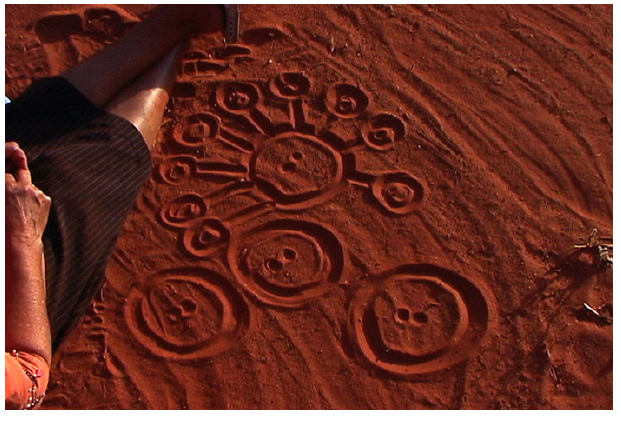
Fig. 4. Sand drawing by Veronica Dobson to illustrate Plant food–Dreaming–Country–People and the elements or values associated with one domain. This drawing of the four domains and some elements preceded that in Fig. 4. (From Dobson et al. 2008, Photo by W. Sati.)